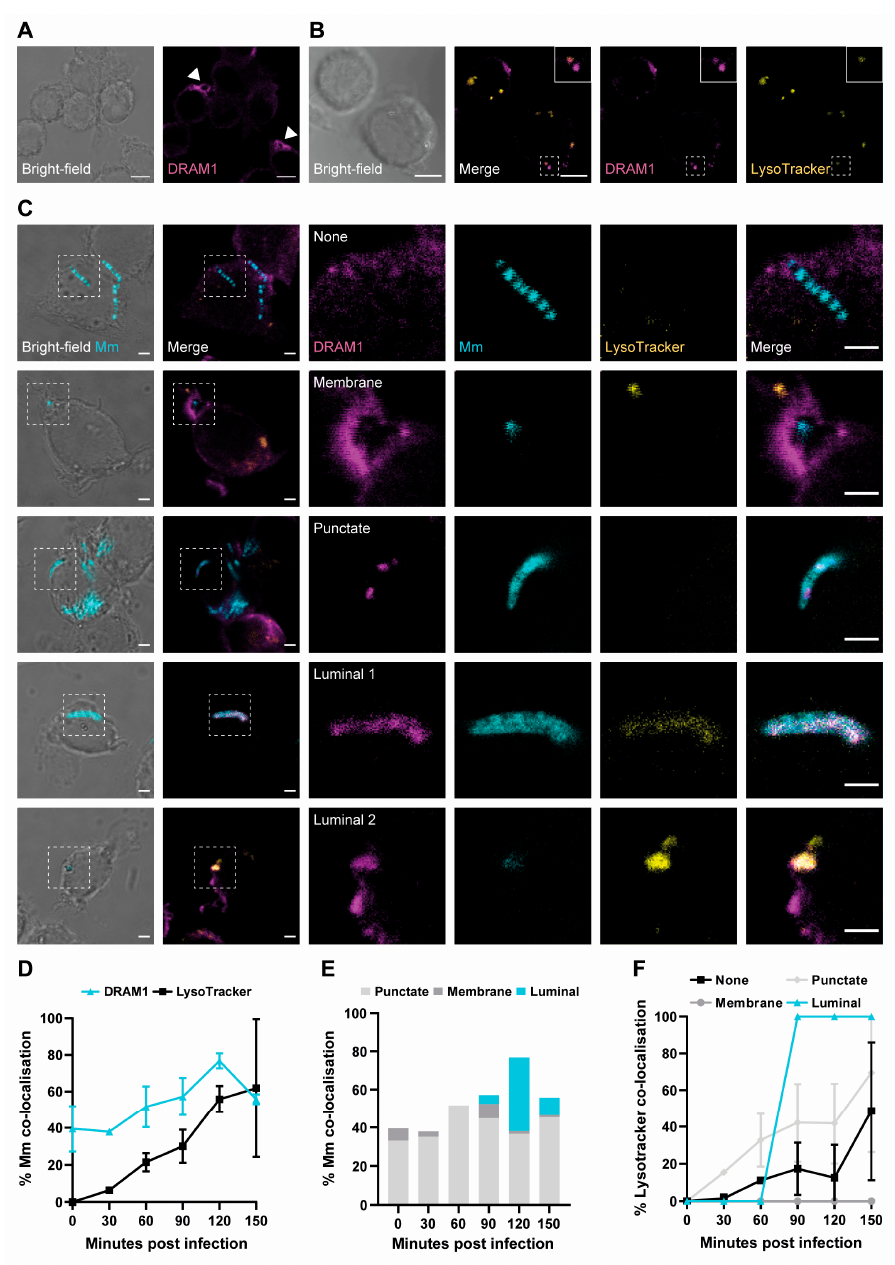
Figure 1. DRAM1 colocalises with acidified mycobacteria-containing vesicles. ( A ) DRAM1 (magenta) localisation at the plasma membrane (arrowheads) of non-infected cells. Scale bars: 5 µm. ( B ) DRAM1 (magenta) colocalisation with acidic vesicles stained by LysoTracker (yellow). A region showing a LysoTracker-positive and a LysoTracker-negative DRAM1-stained vesicle is outlined, with a dotted box in the merged image that is enlarged in the inset. Scale bars: 5 µm. ( C ) Representative examples of DRAM1 (magenta) colocalisation patterns with Mm (cyan), referred to as membrane, punctate, and luminal patterns. An example of DRAM1-negative Mm (none) is also shown. Acidification of Mm -containing vesicles was assessed by LysoTracker staining (yellow). Scale bars: 2 µm. ( D ) Frequency of Mm colocalisation with DRAM1 or LysoTracker over time. ( E ) Frequency of Mm colocalisation with DRAM1 in punctate, membrane, or luminal patterns over time. ( F ) Frequency of LysoTracker colocalisation with DRAM1-negative Mm and DRAM1-positive membrane, punctate, and luminal Mm patterns over time. Data were accumulated from two independent experiments with the following total numbers of Mm observations per time point: 71 for t = 0, 73 for t = 30, 105 for t = 60, 98 for t = 90, 102 for t = 120 and 111 for t = 150